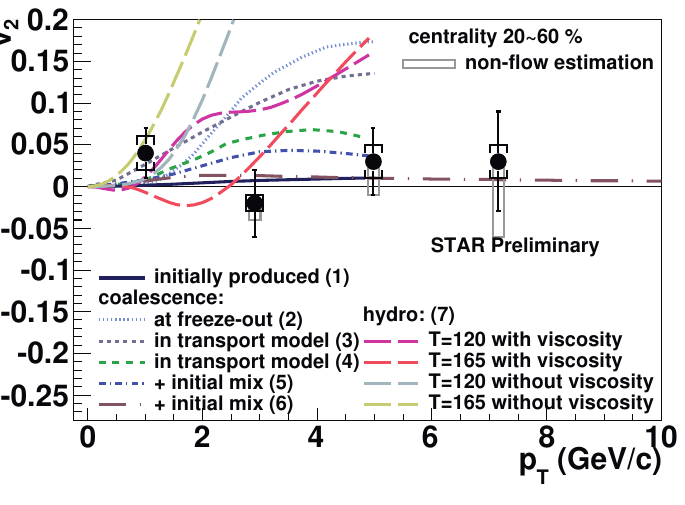
Figure 4. The transverse momentum dependence of azimuthal anisotropy parameter v 2 measured by the STAR experiment in 20-60% most central Au + Au collisions. Taken from Ref.